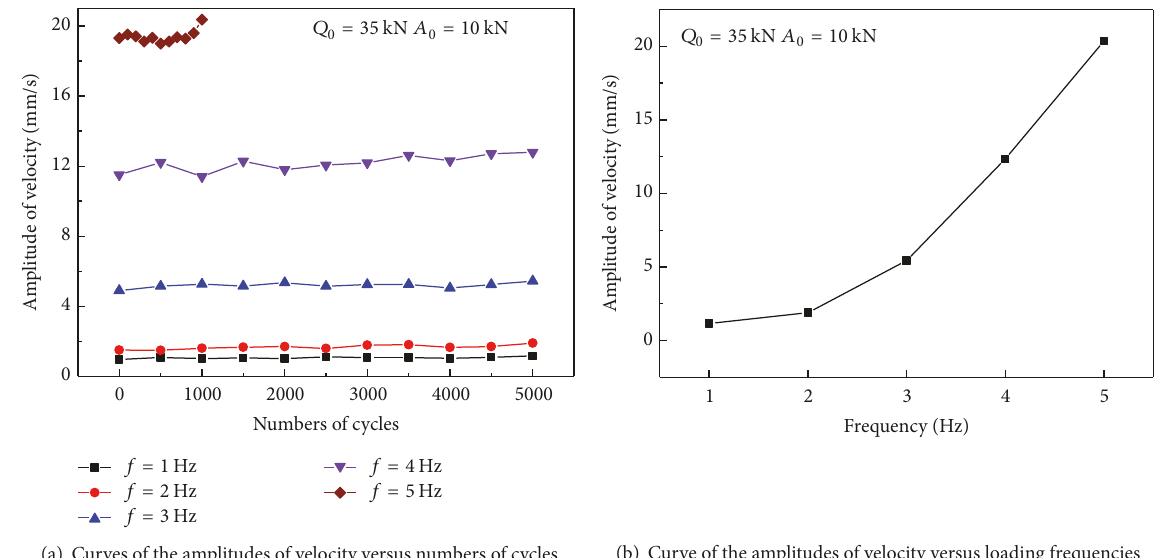
(b) Curve of the amplitudes of velocity versus loading frequencies Figure 14: Variations of the amplitudes of velocity with variable loading frequencies.